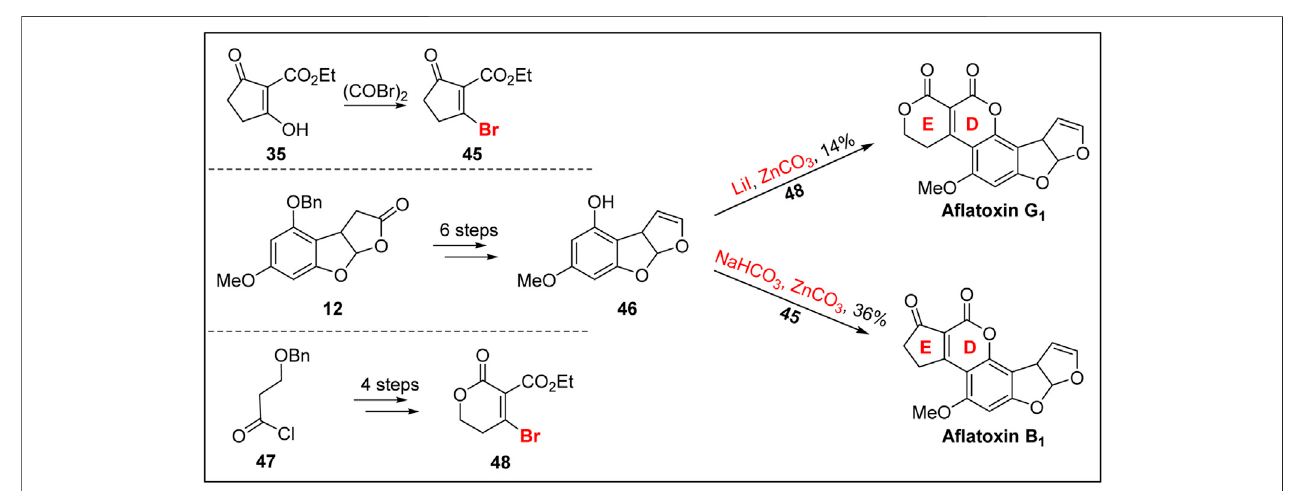
FIGURE 5 | First total synthesis of ( ± )-a fl atoxin G